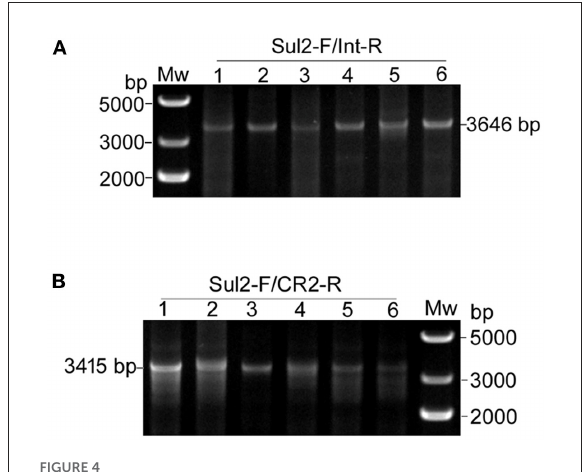
FIGURE4 Detection of pKFattB-GItetWsul2 and pKFattB-CR2sul2 structures in recombinant colonies. PCR amplification using the primer pairs Sul2-F/Int-R and Sul2-F/CR2-R for the detection of GItetWsu2-pKFattB (A) and pKFattB-CR2sul2 (B) structures, respectively. PCR reactions were conducted on the same six recombinant colonies as in Figure